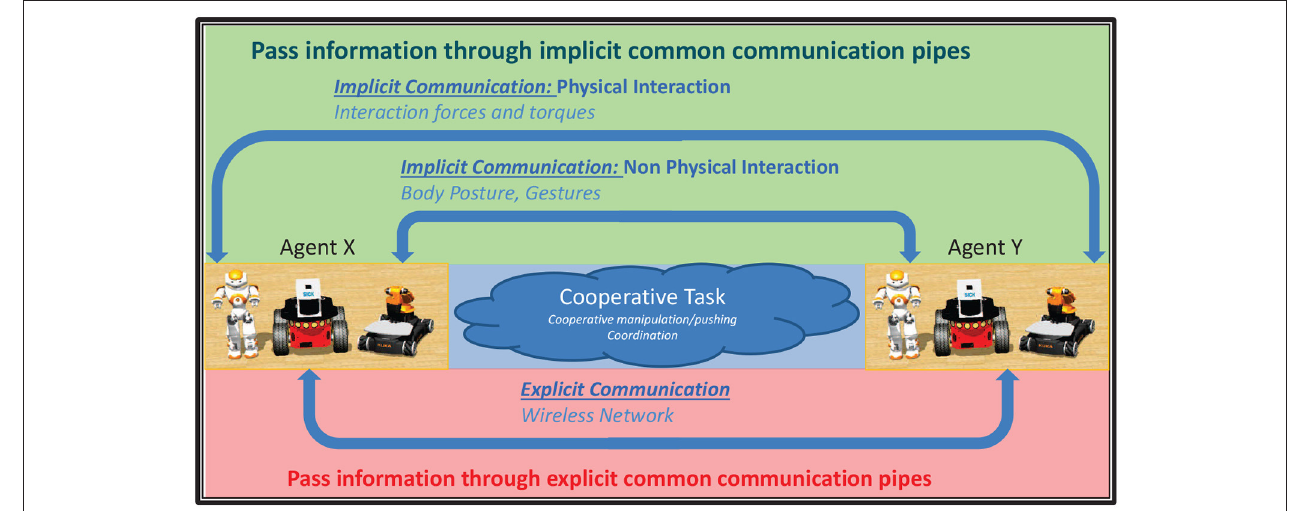
FIGURE 2 | The two types of communication, namely the explicit and the implicit.